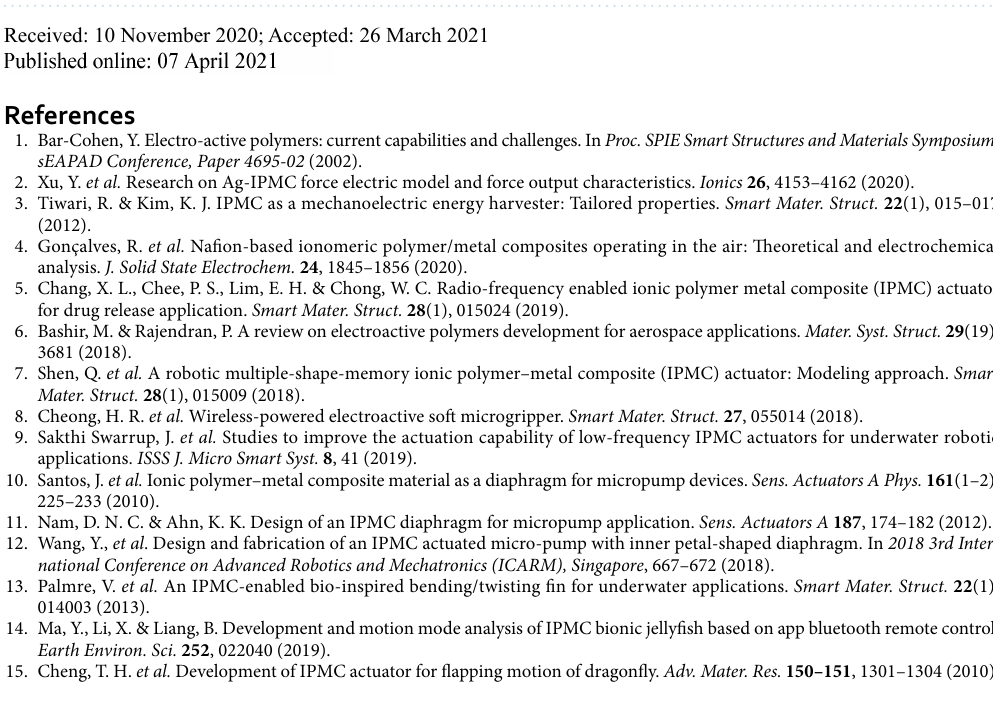
Figure 6. The twist angle of IPMC with patterned electrodes under 0.3 Hz AC Voltage. ( a ) 3v, ( b ) 4v, ( c ) 5v, ( d ) peak-valley angle under different